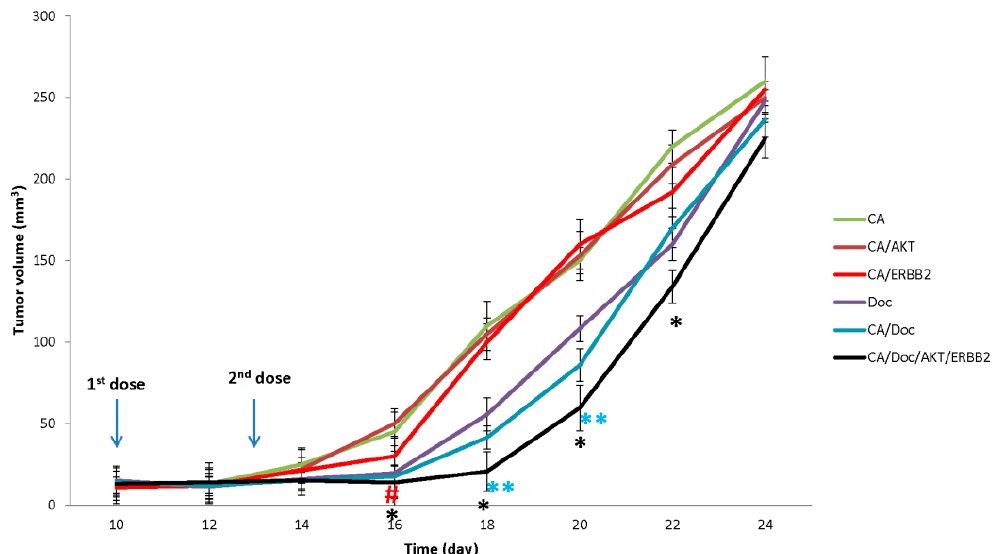
Figure 7. Effect of silencing AKT and ERBB2 pathways on in vivo efficacy of docetaxel. Mice were purchased from Razi Research Institute, Tehran, Iran. Approximately 10 6 4T1 cells were inoculated subcutaneously on the mammary pad of mice. Based on tumor volume calculations, mice were randomized and treated intravenously through tail-vein injection on day 10 and 13. The therapeutics included 100 μ L of carbonate apatite entailing 4 μ L of 1M CaCl 2 and 50 nM of AKT and ERBB2 siRNA plus 1mg/kg Doc. Body weight and tumor outgrowth were monitored every other day. Data is represented as mean ± SD, n = 6 and values are significant when * p value < 0.05 for CA/Doc/AKT/ERBB2 vs CA/Doc, # p value < 0.05 for CA/ERBB2 compared to CA and ** p value < 0.05 for Ca/Doc against Doc. According to the p values calculated in the t-test, treatment of animals with CA / Doc / AKT /